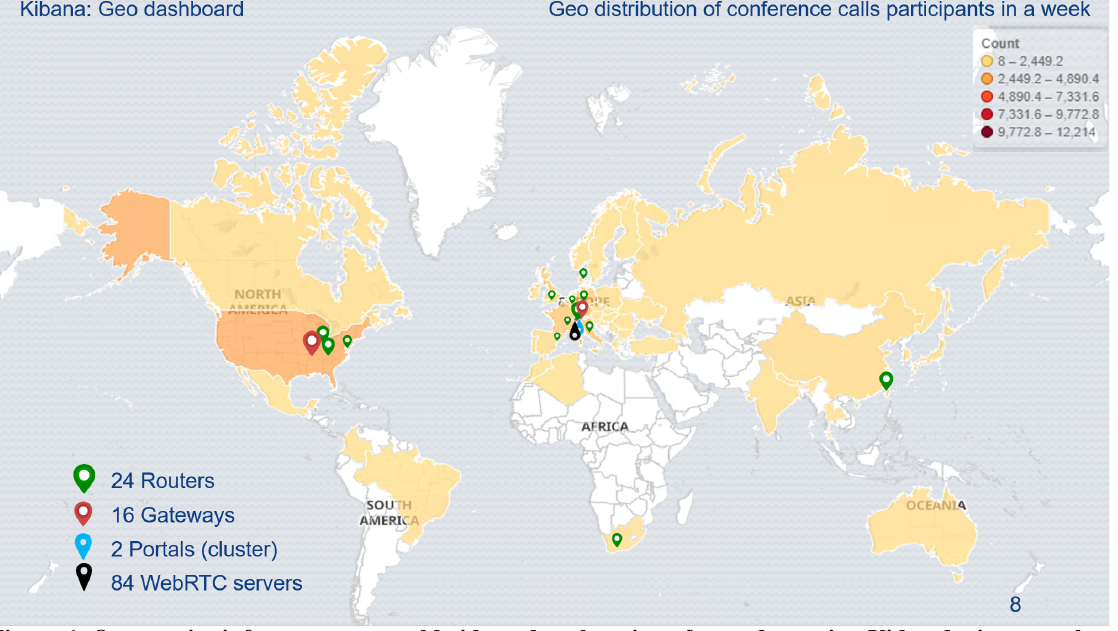
Table 1. Using the extraction power of SQL to create NoSQL documents with all information